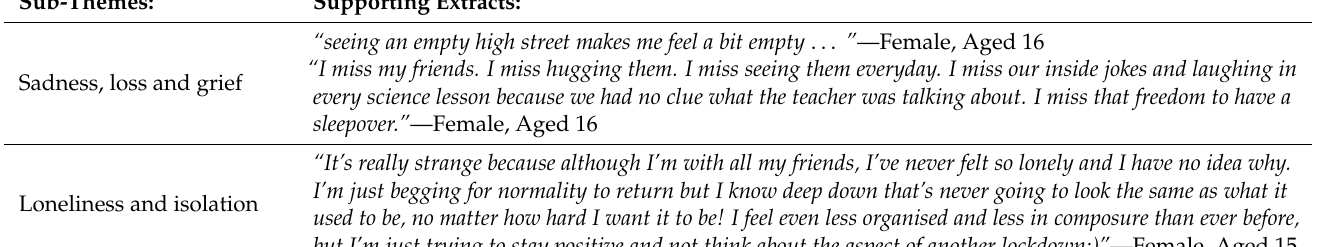
Table 2. Impacts of on young people’s mental health and emotional wellbeing—sub-themes and supporting extracts.